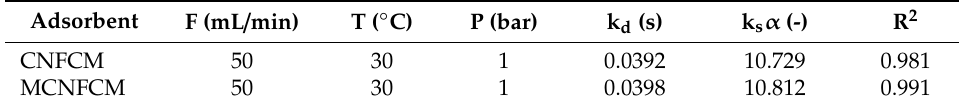
Table 13. Deactivation model parameters in 10% CO 2 inlet.